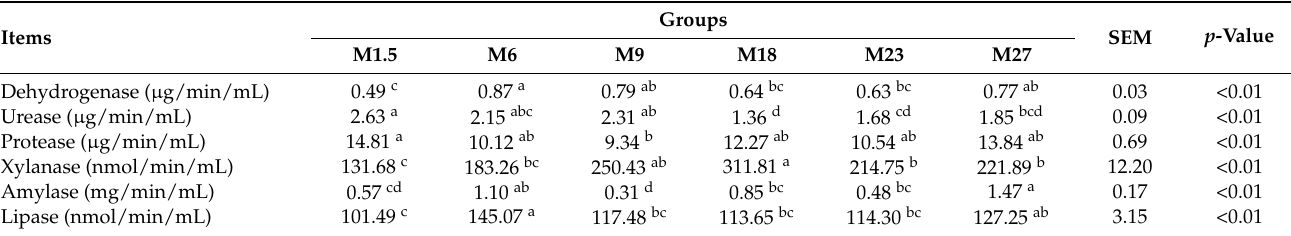
Table 2. The enzyme activity in rumen fluid of dairy